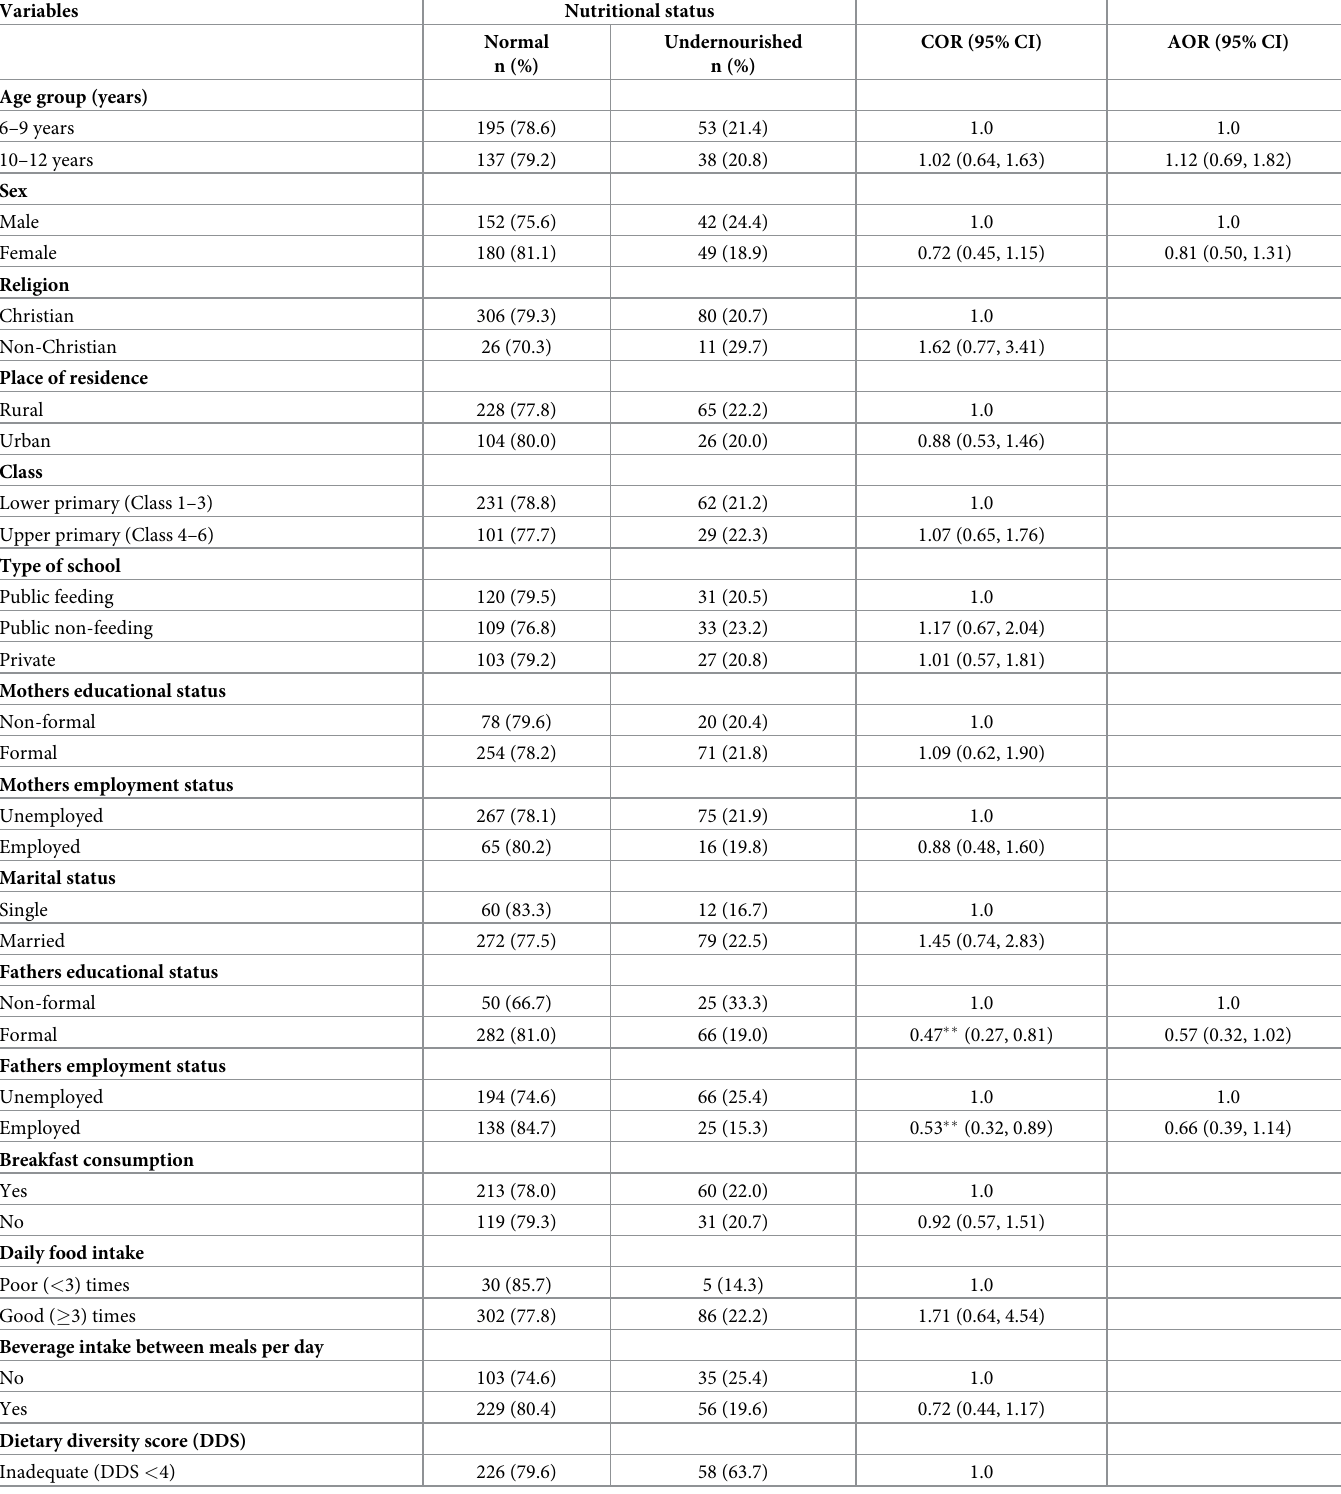
Table 2. Bivariate and multivariable regression analysis of factors associated with